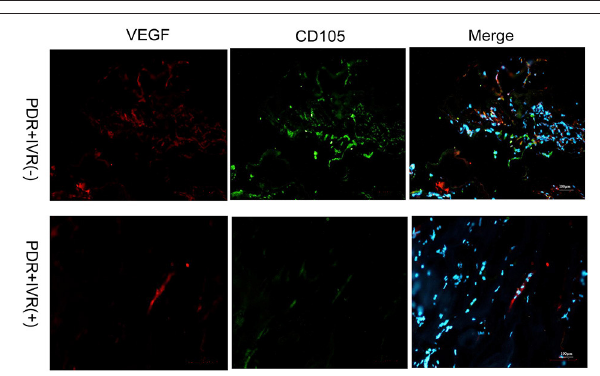
FIGURE 4 | Epiretinal fibrovascular membranes (FVMs) showed strong positive for VEGF and the marker CD105 of neovascular endothelial cells in the Non-IVR group. Scale bars: 100 µ m.